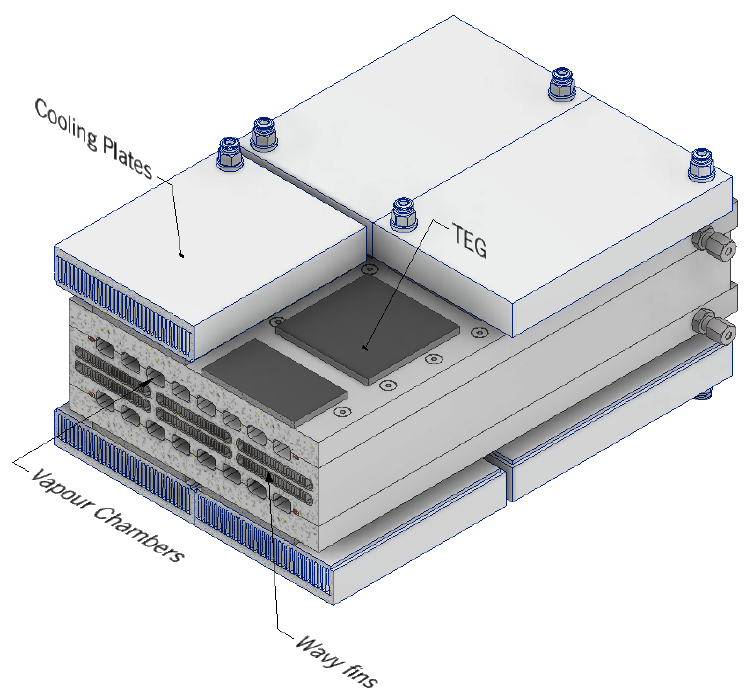
Figure 1. Scheme of the proposed heat exchanger for TCTG system.